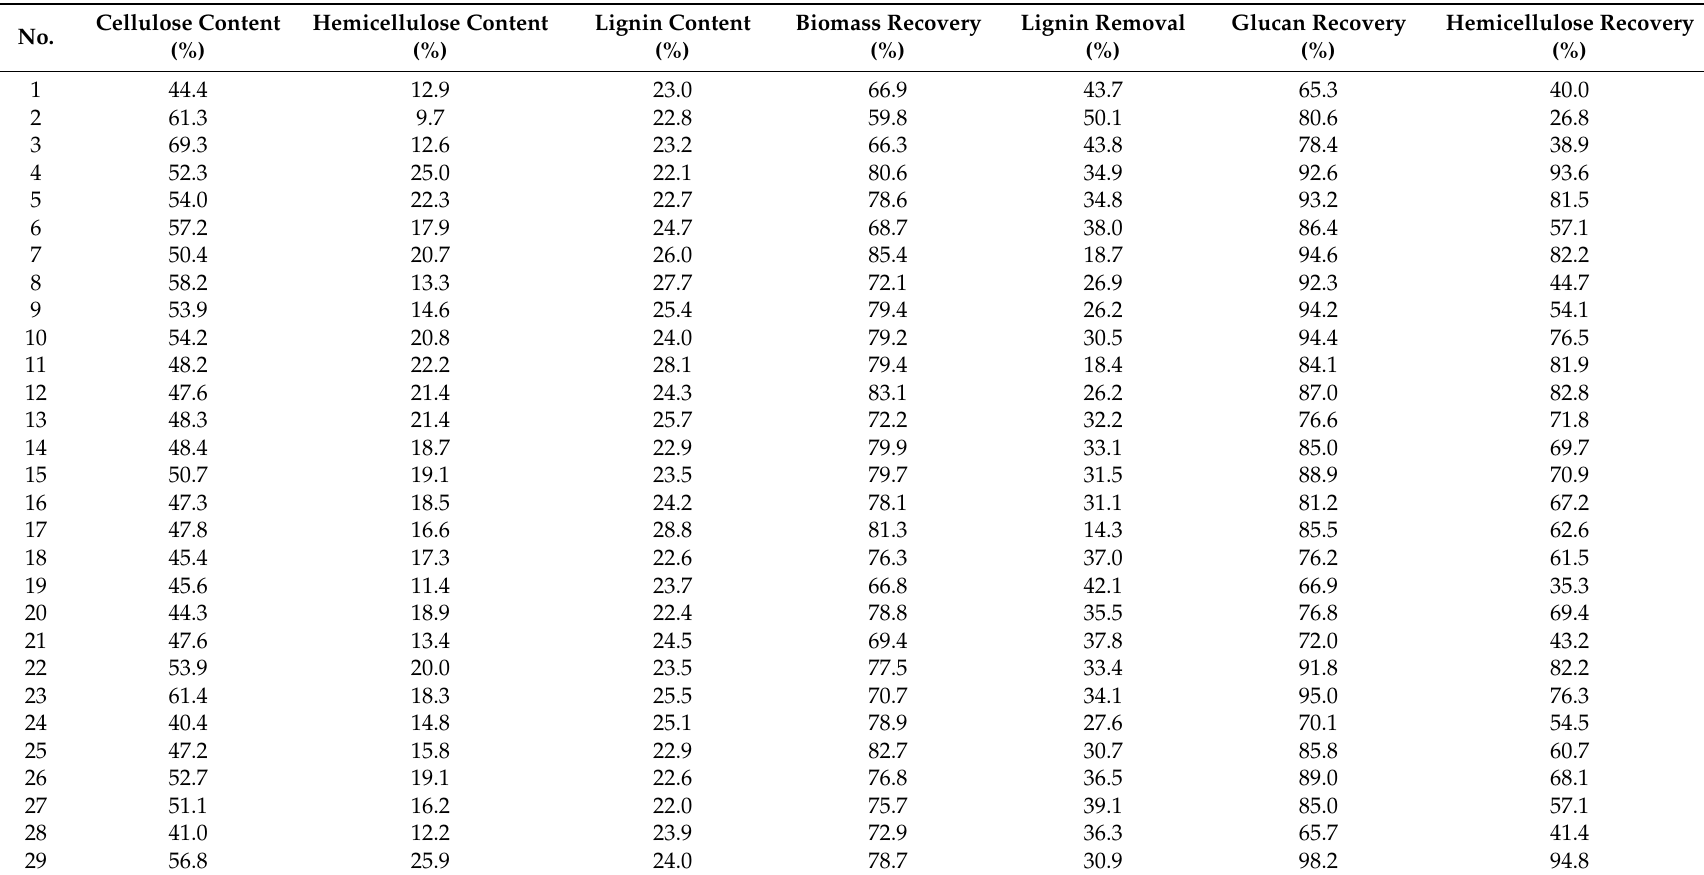
Table 7. Changes in the biomass composition after alkaline